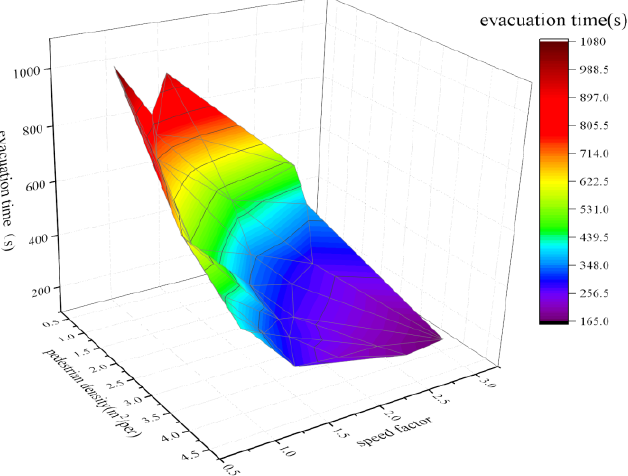
Figure 8. The relationship between speed factor, number of evacuees, and evacuation time.